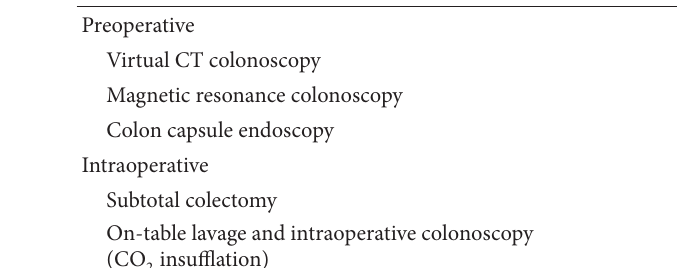
Table 1: Alternative strategies for the identification of synchronous colonic lesions for patients that present with acute colonic cancer requiring emergent